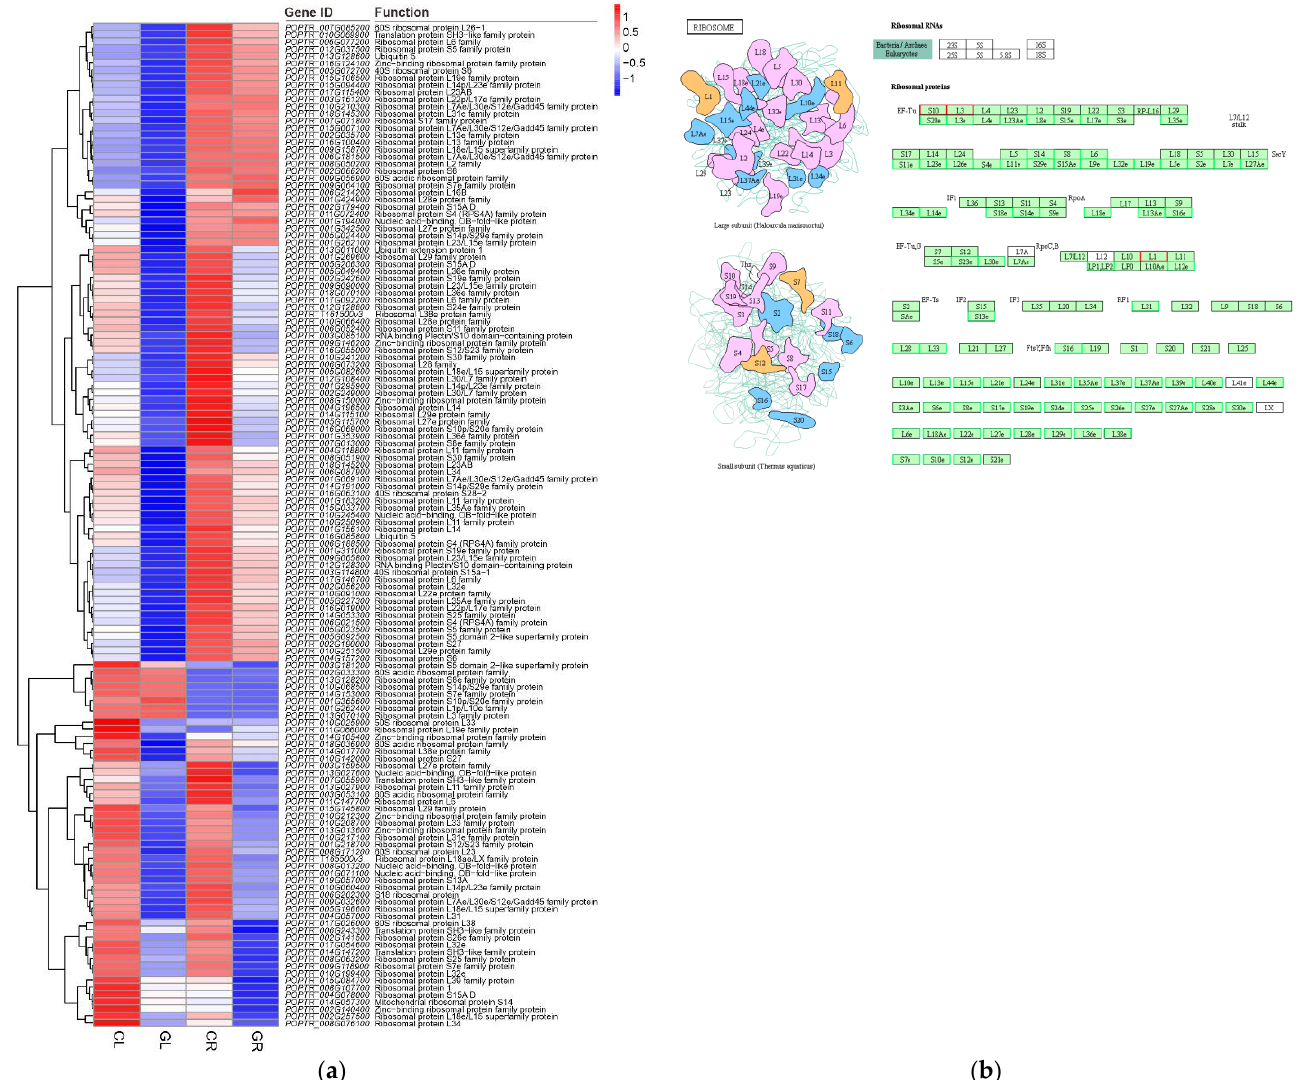
Figure 6. Expression pattern analysis of DEGs in ribosome by the pairwise comparisons of GL vs. CL and GR vs. CR. ( a ) Heatmaps of DEGs in the ribosome pathway; ( b ) KEGG pathway presenting DEGs in ribosome in GL compared with CL. Red boxes indicate upregulation and green boxes indicate downregulation. CL, CR, GL and GR represent the shoots and roots samples of the inorganic N control and the Gln treatment,